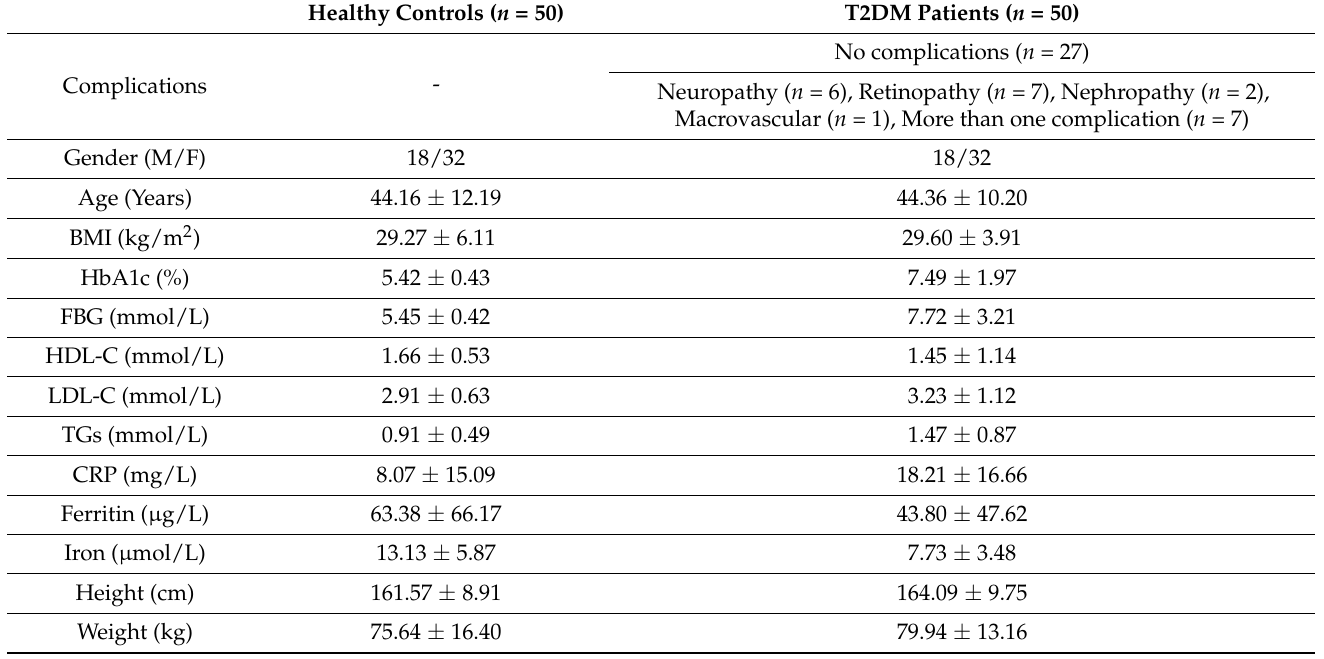
Table 1. Demographic, clinical, and biochemical characteristics of healthy controls and T2DM patients. Abbreviations: BMI, body mass index; CRP, C-reactive protein; FBG, fasting blood glucose; HDL-C, high-density lipoprotein cholesterol; LDL-C, low-density lipoprotein cholesterol; T2DM, type 2 diabates mellitus; TGs, triglycerides. Healthy Controls ( n = 50) T2DM Patients ( n = 50) No complications ( n = 27) Complications - Neuropathy ( n = 6), Retinopathy ( n = 7), Nephropathy ( n = 2), Macrovascular ( n = 1), More than one complication ( n = 7) Gender (M/F) 18/32